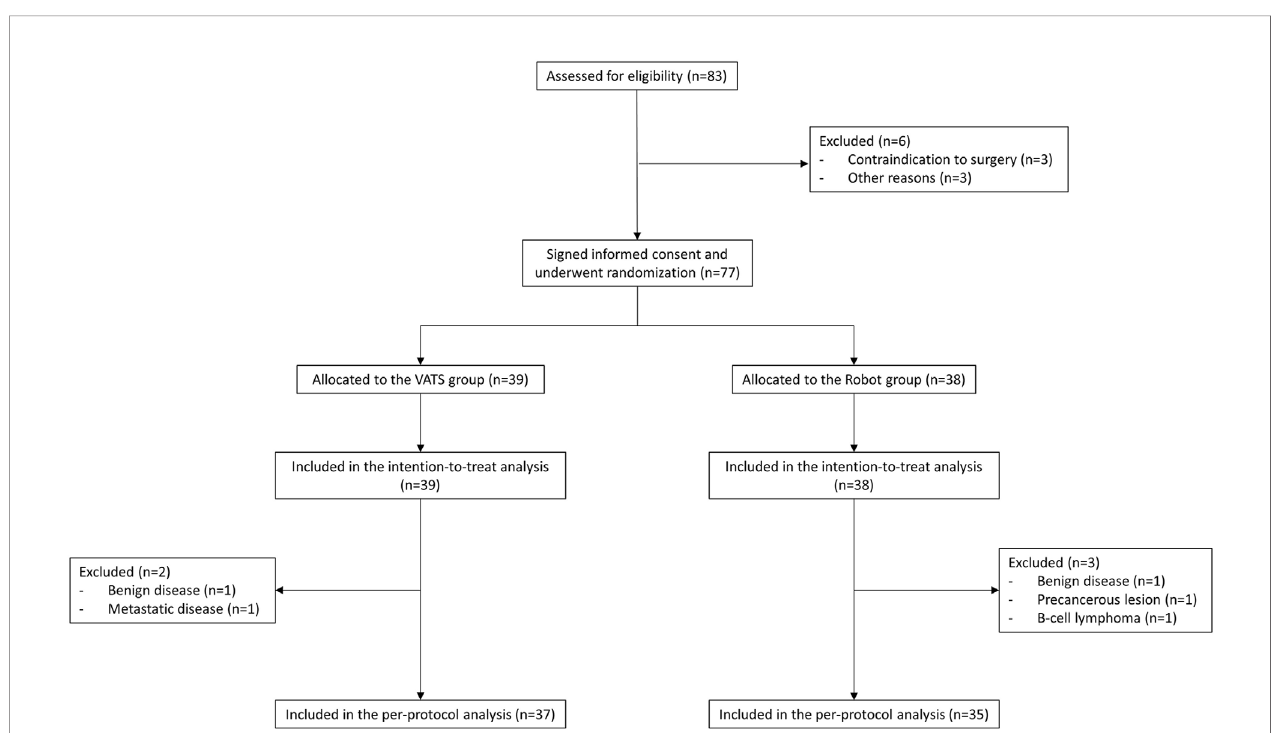
FIGURE 1 | CONSORT fl ow diagram of enrollment, randomization, and analysis.